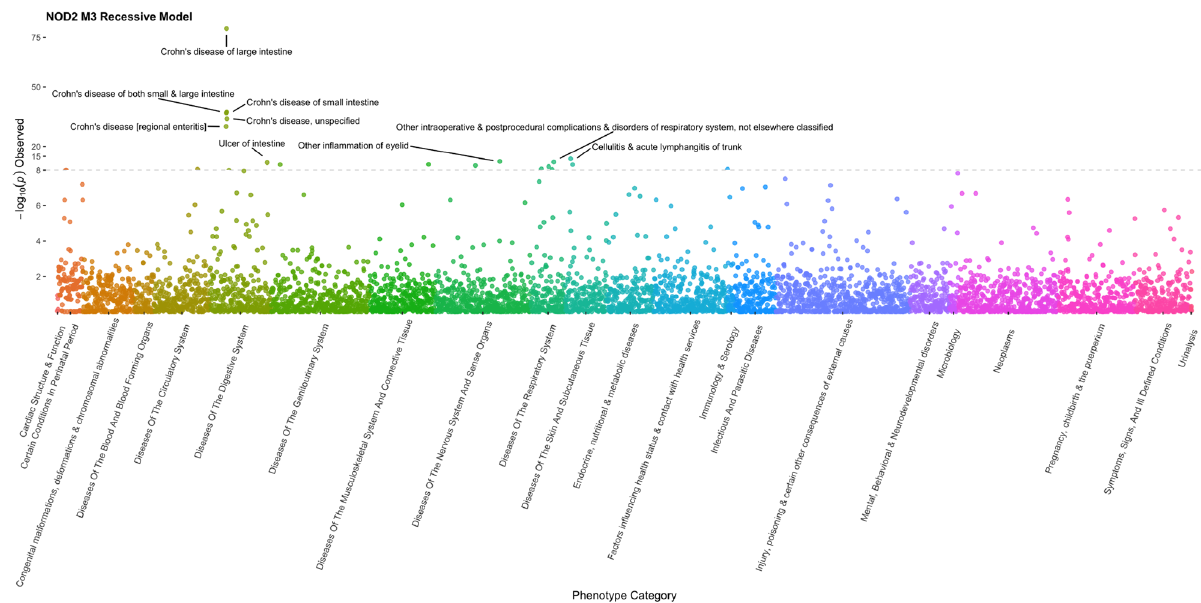
Figure 2. Phenome wide association analysis (PheWAS) of ICD diagnostic codes with biallelic recessive genotypes of NOD2. Analysis shows that NOD2 recessive status significantly associates with Crohn’s disease and related